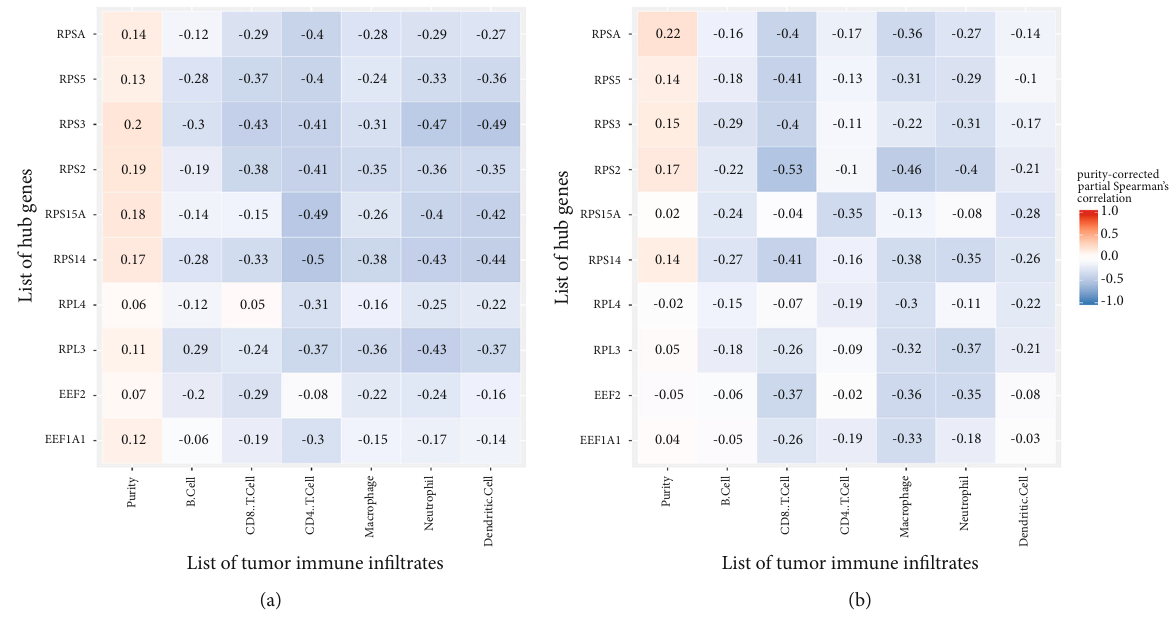
Figure 7: The correlation between hub genes and tumor-in fi ltrating immune cells (TIICs). (a) The correlation displayed in colon cancer of The Cancer Genome Atlas (TCGA); (b) the correlation displayed in rectal cancer of TCGA. Blue indicated negative purity-corrected partial Spearman ’ s correlation while red indicated positive